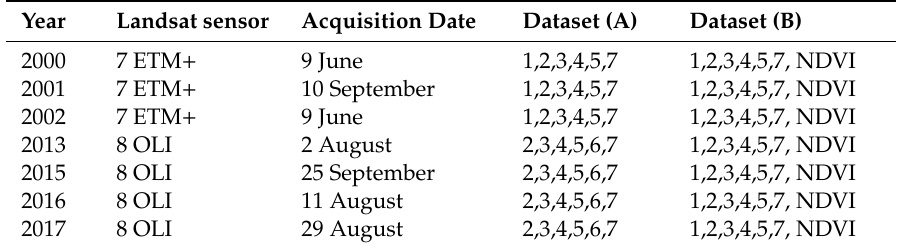
Table 1. Landsat imagery (path217 / raw74) with less than 1% clouds at selected years and dates.